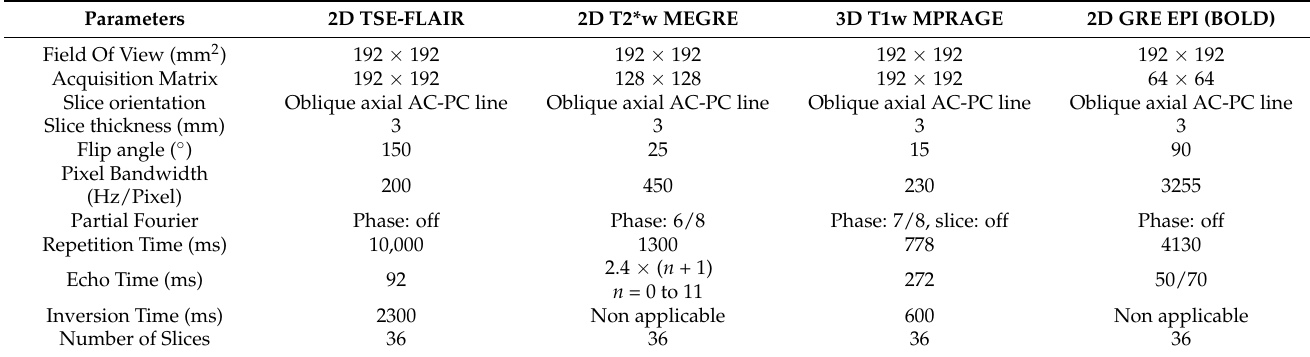
Table 1. Sequence